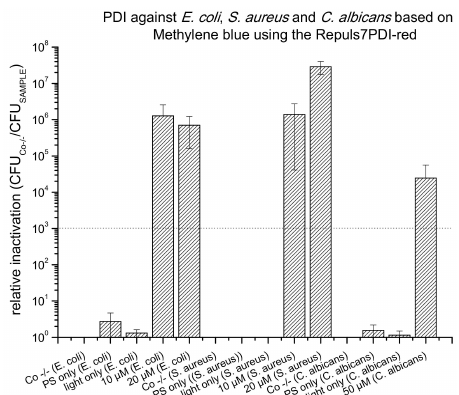
Figure 5. Photodynamic Inactivation of E. coli , S. aureus and C. albicans shown as relative inactivation (CFU Co − / − / CFU sample ). Methylene blue was photoactivated using the Repuls7PDI-red (radiant exposure: 25.6 J · cm − 2 , irradiance: 26.3 mW · cm − 2 ). The bars represent the average of three independent biological replicates including the standard deviations as error bars. The black dashed line corresponds to a reduction of 3 log 10 (99.9% killing e ffi cacy). Three controls were included in this experiment. Co − / − : double negative control; PS only: dark control; and light only: light control.